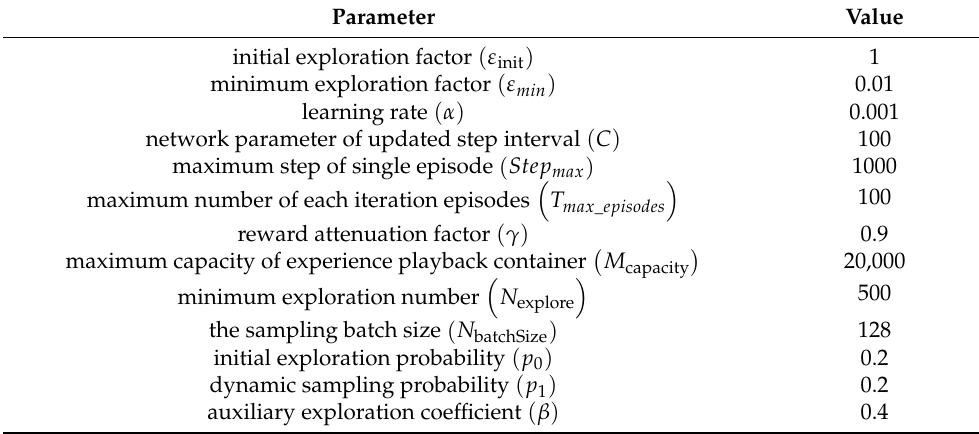
Table 1. Experimental training parameters’ settings. Parameter Value initial exploration factor ( ε init ) 1 minimum exploration factor ( ε min ) 0.01 learning rate ( α ) 0.001 network parameter of updated step interval ( C